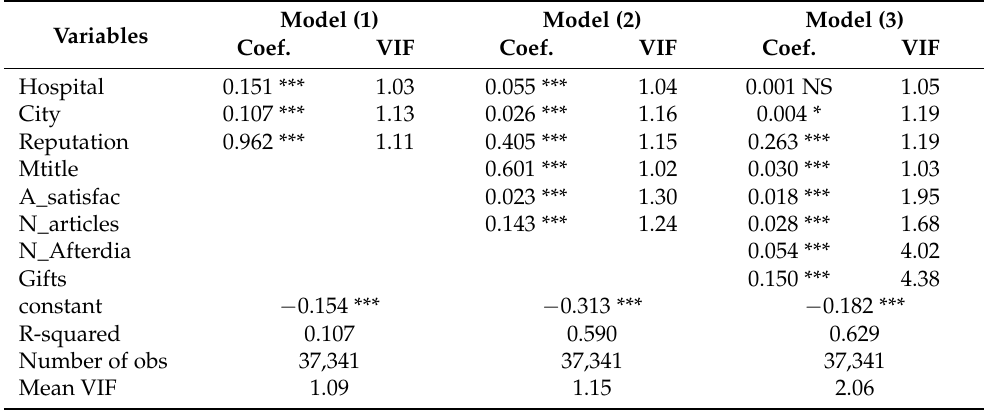
Table 3. Analysis of regression